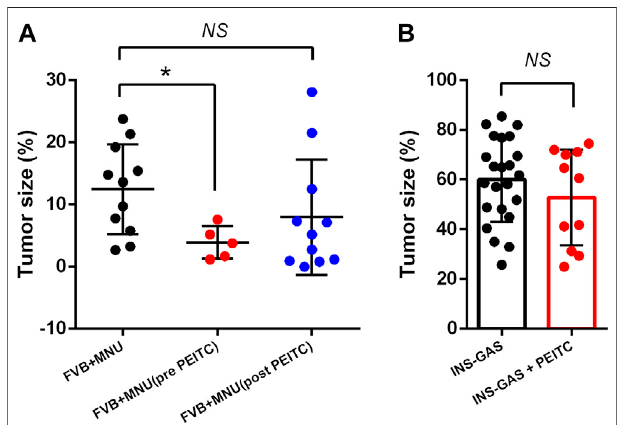
FIGURE1 | Tumorsizeofgastriccancerinmicethatcompletedthestudy periodof45 – 50 weeks.FVB micereceivedMNU for 10 weeks ( n (cid:1) 11) orMNU together with PEITC (3 – 5 µmol PEITC/g diet) for 10 weeks ( n (cid:1) 5) or post MNU treatment ( n (cid:1) 11) (A) and in INS-GAS mice with or without PEITC (3 – 5 µmol PEITC/g diet) for 10 weeks (B) . Mean ± SEM. Tumor size expressed asvolumedensity(%ofglandularareaoccupiedbytumor).ANOVA+Dunnett ’ s test (1-tailed) in (A) , student t -test in (B) . * p < 0.05; NS, not signi fi cant; PEITC, phenethyl isothiocyanate; MNU,